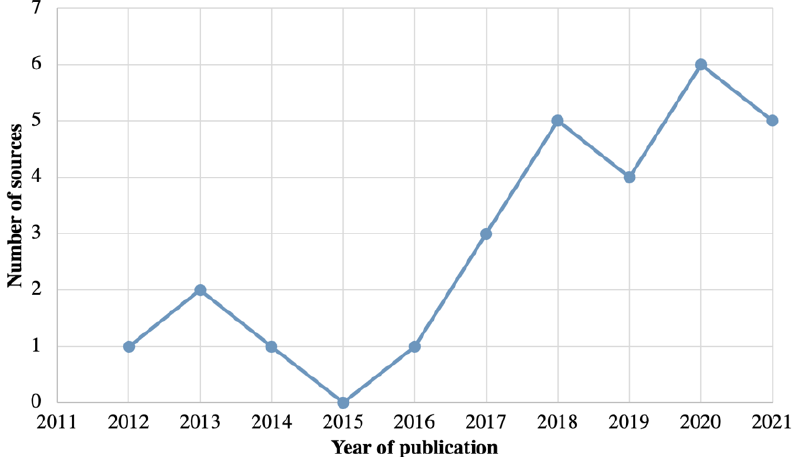
Figure 2. Number of sources published from 2011 to 2021 on the digital marketing monitoring of BMS and FBHFSS targeted for ICA ( n = 28). BMS: breast-milk substitutes; FBHFSS: foods and beverages high in saturated fat, salt, and/or free sugars; ICA: infants, children, and adolescents.